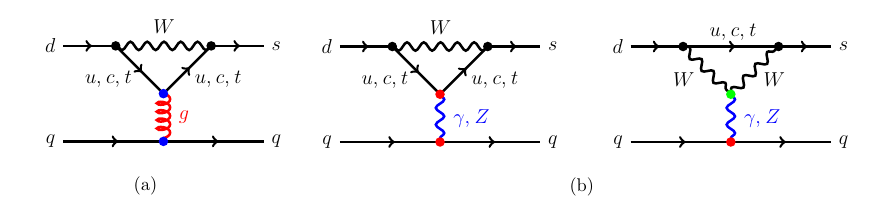
Figure 1. Quark level diagrams for the weak processes involving kaons or hyperons that contribute to the CP-odd phases in the standard model: (a) QCD-penguin operators and (b) electroweak penguin operators. This figure was created using a modified script from Ref.